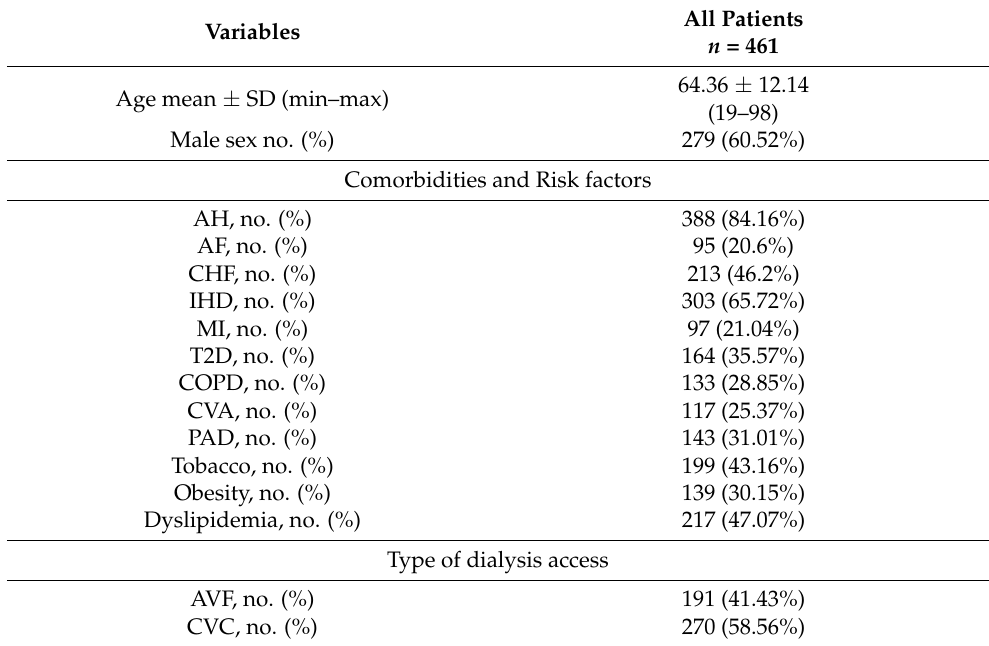
Table 1. Demographic, comorbidities, risk factors, type of dialysis access, and outcome of all patients included in the analysis.